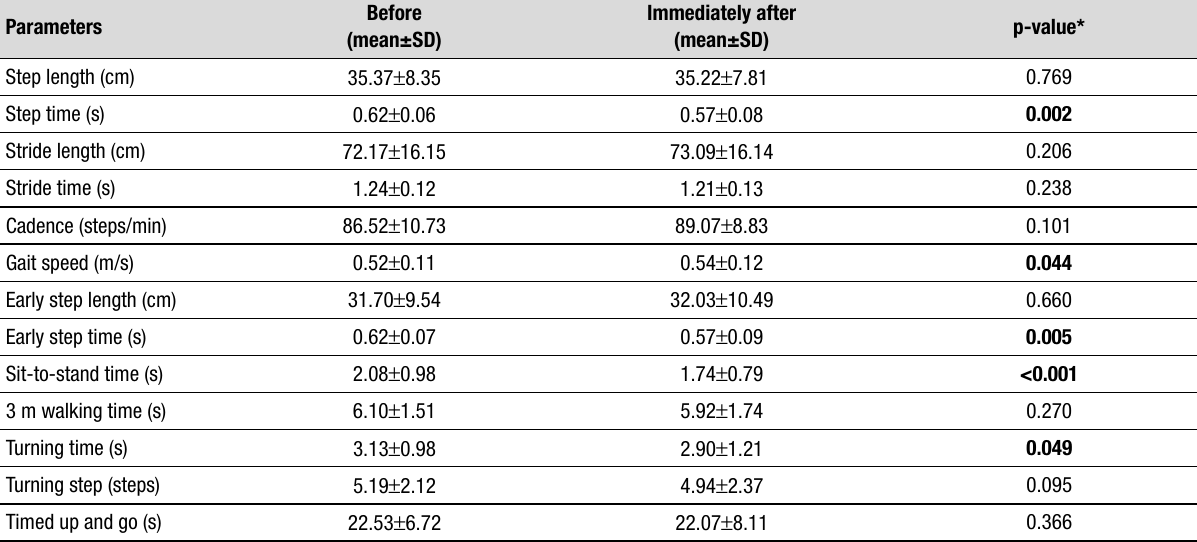
Table 3. Comparison of gait and mobility parameters between before and immediately after applied with action observation.